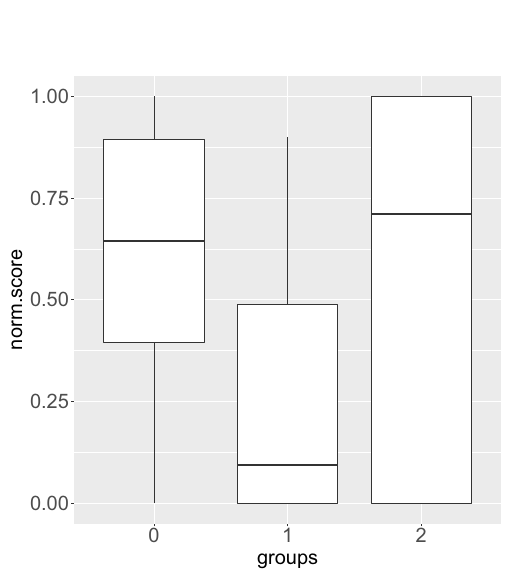
Figure 4: Box plot showing the distribution of memory scores achieved by participants for the di ff erent verbalization mechanisms; 0: “ optimal, ” 1: “ random, ” and 2: “ single.